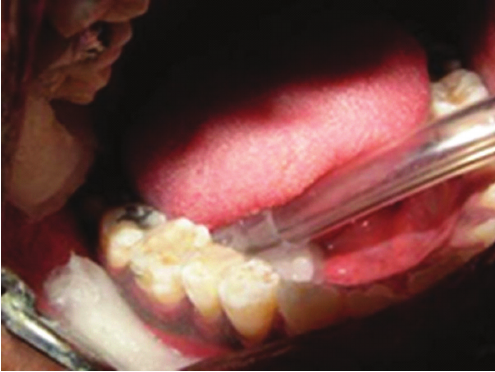
Figure 6: After light cure composite